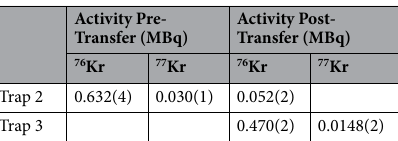
Table 3. The decay-corrected activity measurements of krypton pre and post transfer from trap 2 to trap 3.